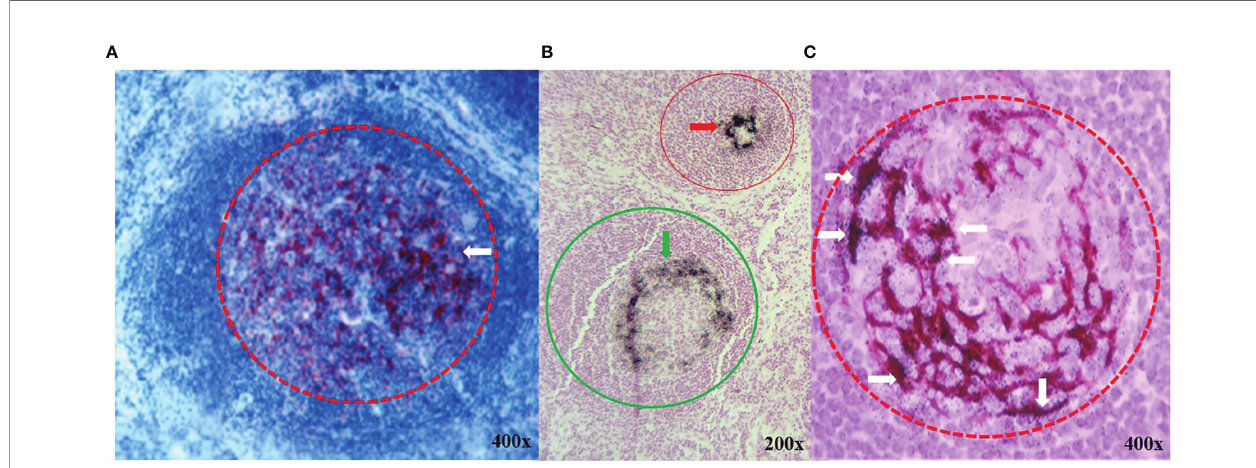
FIGURE 2 | TAG-72 expression in germinal centers of lymphoid follicles in extraregional tumor draining lymph nodes. (A) Immunohistochemical (IHC) staining with murine monoclonal antibody (mMoAb) CC49 (dark red) demonstrates early polarization (white arrow) of TAG-72 toward the periphery of a germinal center (red circle) in a reactive lymphoid follicle. (B) Black autoradiography silver grains (ARGs) located in demonstrate the injected 125 I- mMoAb CC49 in two germinal centers (red and green circles). TAG-72 distribution varies from an acentric pattern (green arrow) in the germinal center of a reactive lymphoid follicle (green circle) as compared to a dense circular peripheral pattern in the germinal center (red arrow) of a smaller lymphoid follicle (red circle). (C) mMoAb CC49 IHC staining (brown) and black ARGs demonstrate co-localization of TAG-72 (white arrows) in an acentric dendritic pattern in a reactive germinal center (red dashed circle). In stark contrast are the 74 (34.9%) patients with primary or recurrent CRC who lacked evidence of gross tumor and TAG-72- positive tissue at the end of surgery (red dotted line). For those patients with primary CRC, the 5-year OS was independent of the pathologic stage (38). For patients with recurrent disease, the 5-year survival identi fi ed a population of patients who bene fi tted from TAG-72 ADCS (13, 14).